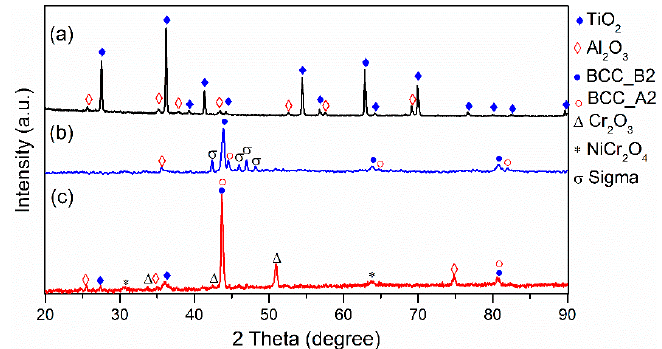
Figure 8. XRD patterns of the oxidized ( a ) Ti6Al4V at 700 °C, ( b ) HEA at 700 °C, and ( c ) HEA at 800 °C for 45